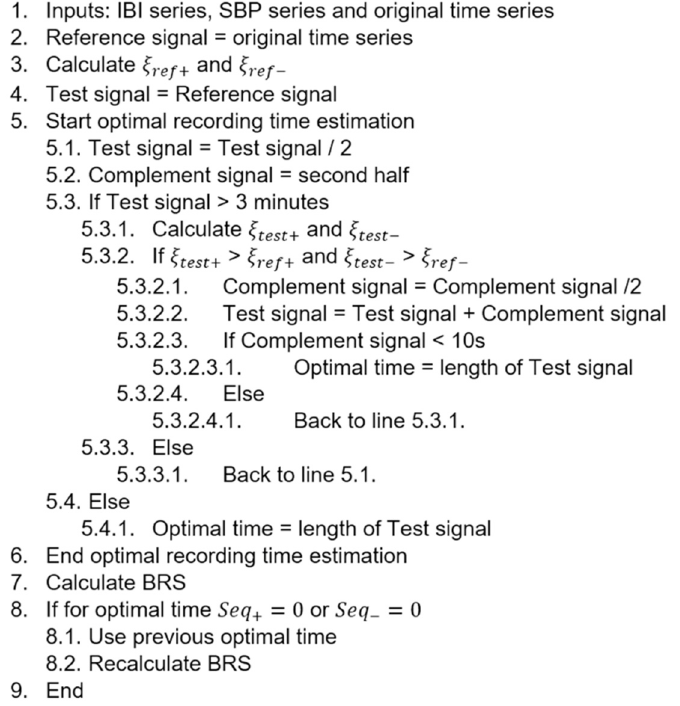
Figure 2. Algorithm for estimation of the optimal recording time for assessment of BRS with the delayed method.